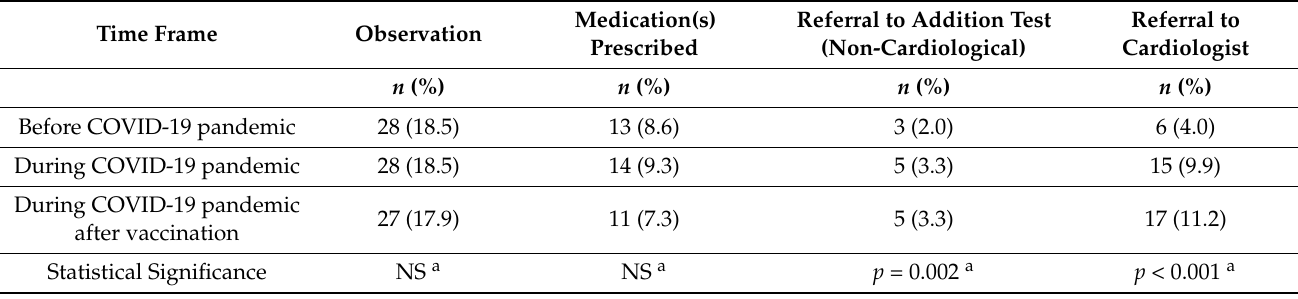
Table 6. Actions taken for patients at